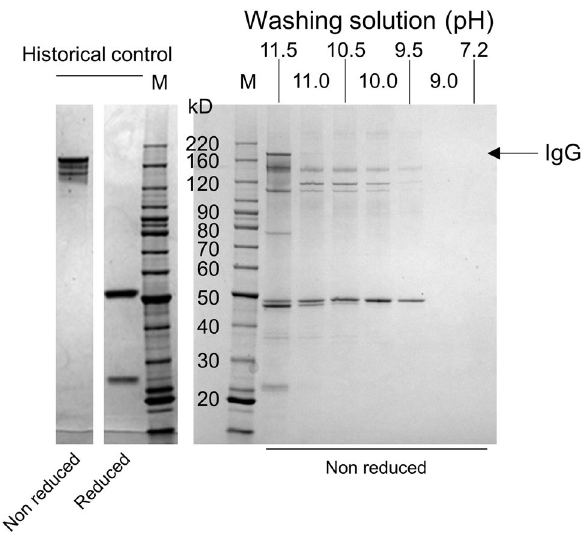
Figure 4. SDS PAGE analysis of washing fraction of IgG-C. M means a molecular marker. Molecular masses are